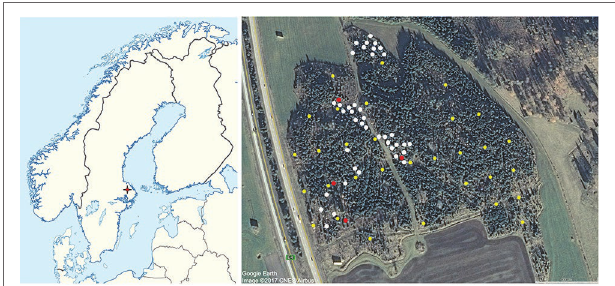
FIGURE 1 | Location of 40 trees used for isolation and spore trapping (white), 31 plots used for damage assessment and dendrochronology (yellow), and location of the four plots where the 24 trees used for physiological measurements were located within the affected stand (red). Image on the left modified from NordNordWest - own work, using World Data Base II data, CC BY-SA 3.0. Image on the right modified from Google Earth Image © 2017